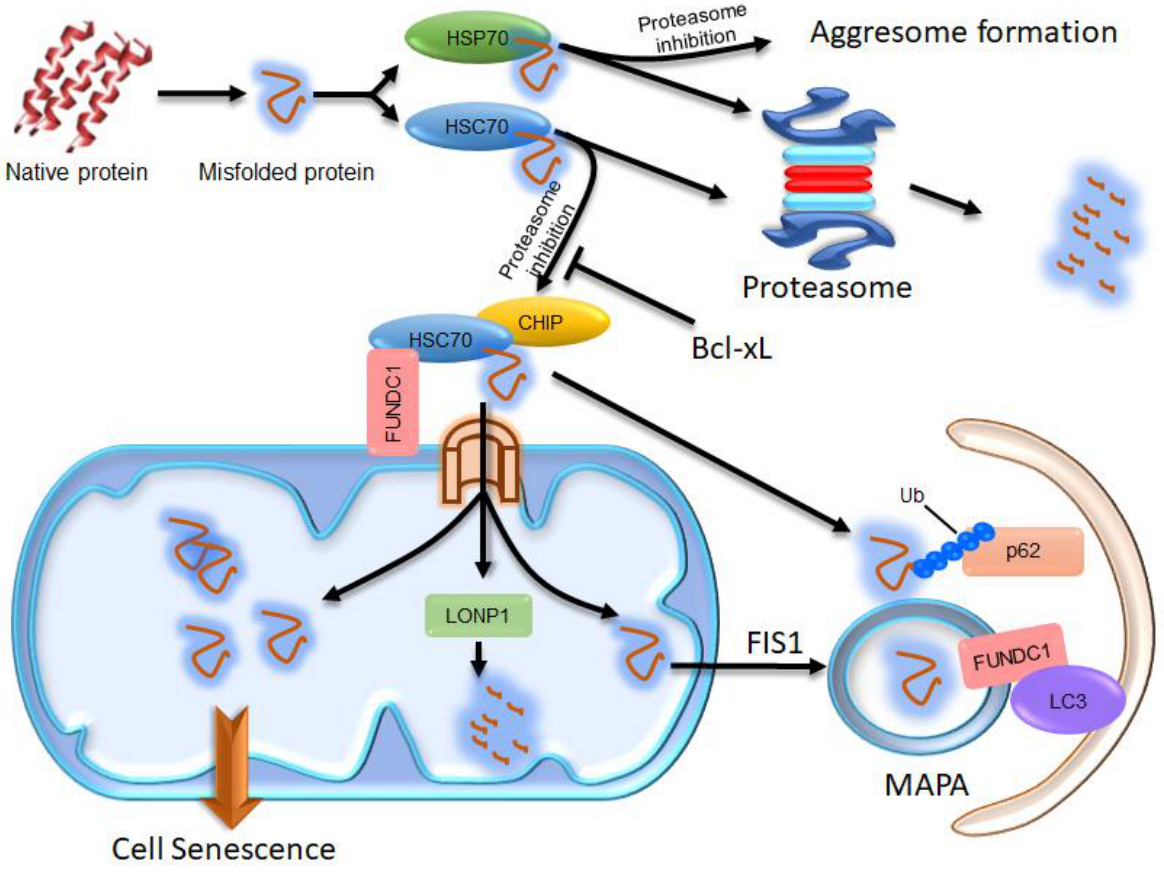
FIGURE 1: Illustration of the compensatory degradation of proteasomal substrates. The cytosolic chaperones HSP70 and HSC70 take their clients to the proteasome for degradation. If proteasomal activity is inhibited, HSP70 proteins take their clients to the microtubule organi- zation center to form aggresomes, which may facilitate the autophagic degradation of the client proteins. HSC70 proteins, however, take their clients to mitochondria through the interaction of HSC70 with FUNDC1. Some of the client proteins are then imported into the mito- chondrial matrix via the TOM/TIM complex and degraded by LONP1. The remains of the client proteins imported into the mitochondrial matrix may concentrate in certain region and become segregated from the mitochondrial network in a FIS-dependent manner to form MAPAs. The HSC70 clients at the surface of mitochondria can be ubiquitinated by the E3 ligase CHIP, which endows them with the ability to recruit p62 proteins. The ubiquitinated proteins and p62 at the surface of mitochondria and some of the mitochondrial membrane pro- teins, including FUNDC1, are all incorporated into the MAPAs. FUNDC1 can mediate recognition of the MAPAs by autophagosomes via its interaction with LC3. If the proteasomal client proteins imported into the mitochondrial matrix are not cleared in time, excessive accumu- lation of these proteins may disturb the mitochondrial function, consequently resulting in cellular